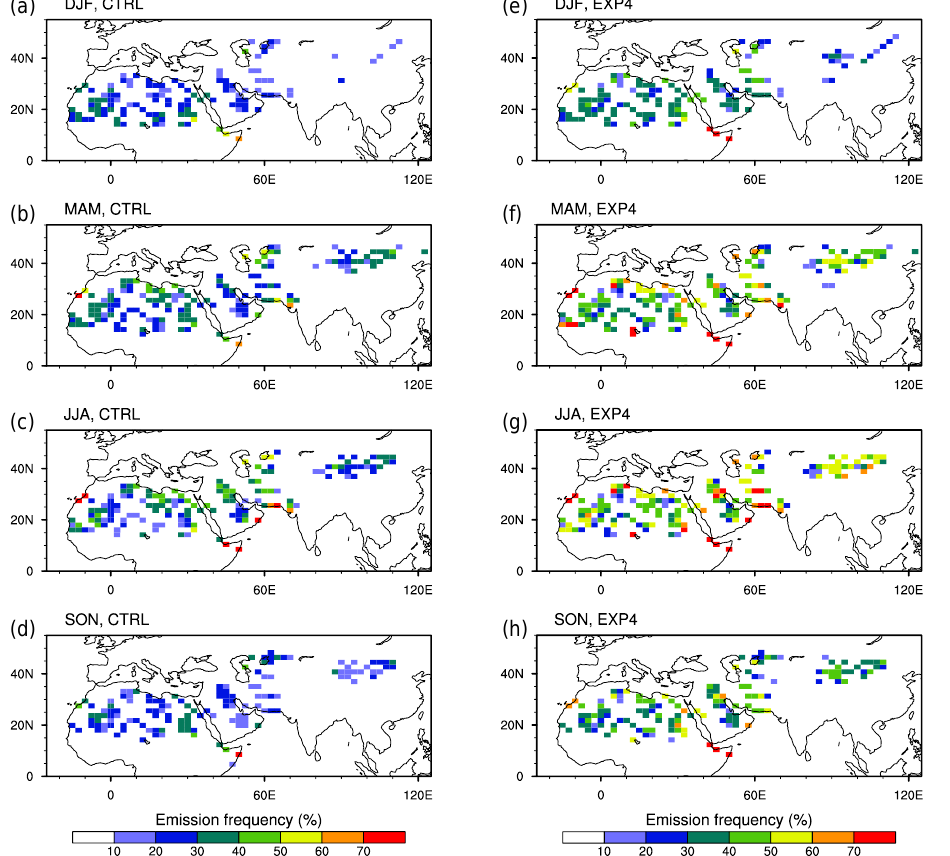
Figure 20. Frequency of occurrence (unit: %) of dust emission fluxes stronger than 10 − 9 kg − 2 s − 1 in Africa and Asia in the CTRL simulation (left column) and in EXP4 (right column). Different rows correspond to different seasons: December–January–February (DJF), March–April– May (MAM), June–July–August (JJA), and September–October–November